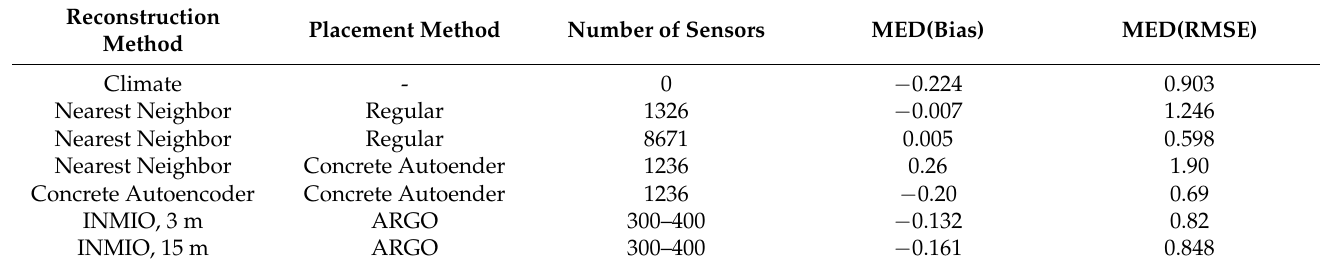
Figure 15. The accuracy of temperature field reconstruction against the original reanalysis data is shown for the Concrete Autoencoder (CA), climate, and for Nearest Neighbor (NN) reconstruction and for different sensor placement methods. The RMSE and bias time series are based on data from the test dataset. The accuracy of reanalysis (INMIO) against ARGO float measurements is also shown. Table 1. Accuracy of the temperature field reconstruction at 9 m for different sensor placement